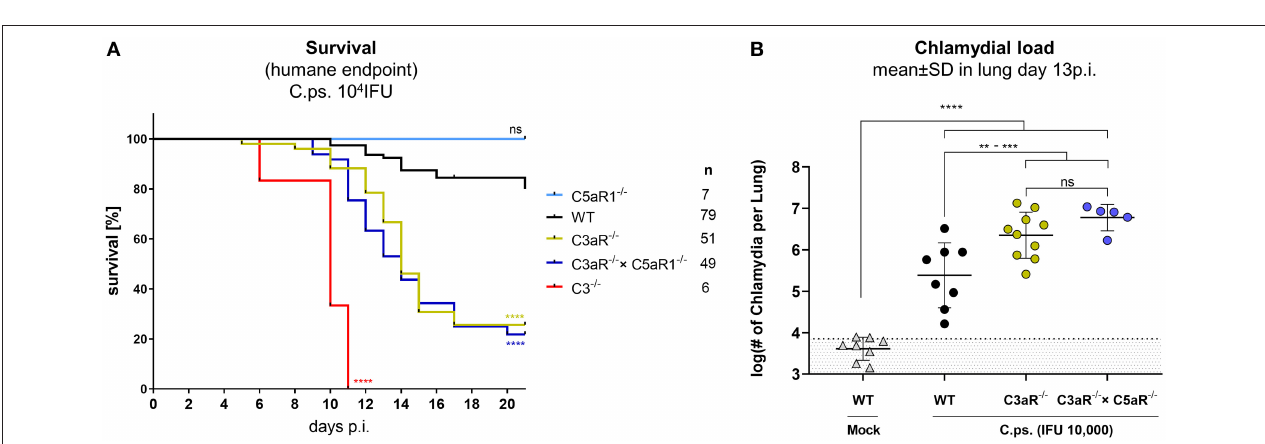
FIGURE 4 | C3a receptor (C3aR) but not C5a receptor 1 (C5aR1) is protective against C. psittaci. WT, C3 − / − and C3aR − / − and/or C5aR1 − / − mice were challenged with 10 4 IFU of Chlamydia. Under close monitoring and using humane endpoint defining criteria survival was assessed (A) . To permit comparison, the chlamydial burden in the lung (of additional mice) was determined on day 13 p.i (B) . Statistical analysis was performed by log-rank Mantel-cox test (A) or by One-way ANOVA followed by Bonferroni post-test (B) . Statistical significance according to the calculated p -value: * p ≤ 0.0332; ** p ≤ 0.0021; *** p ≤ 0.0002; **** p ≤ 0.0001.